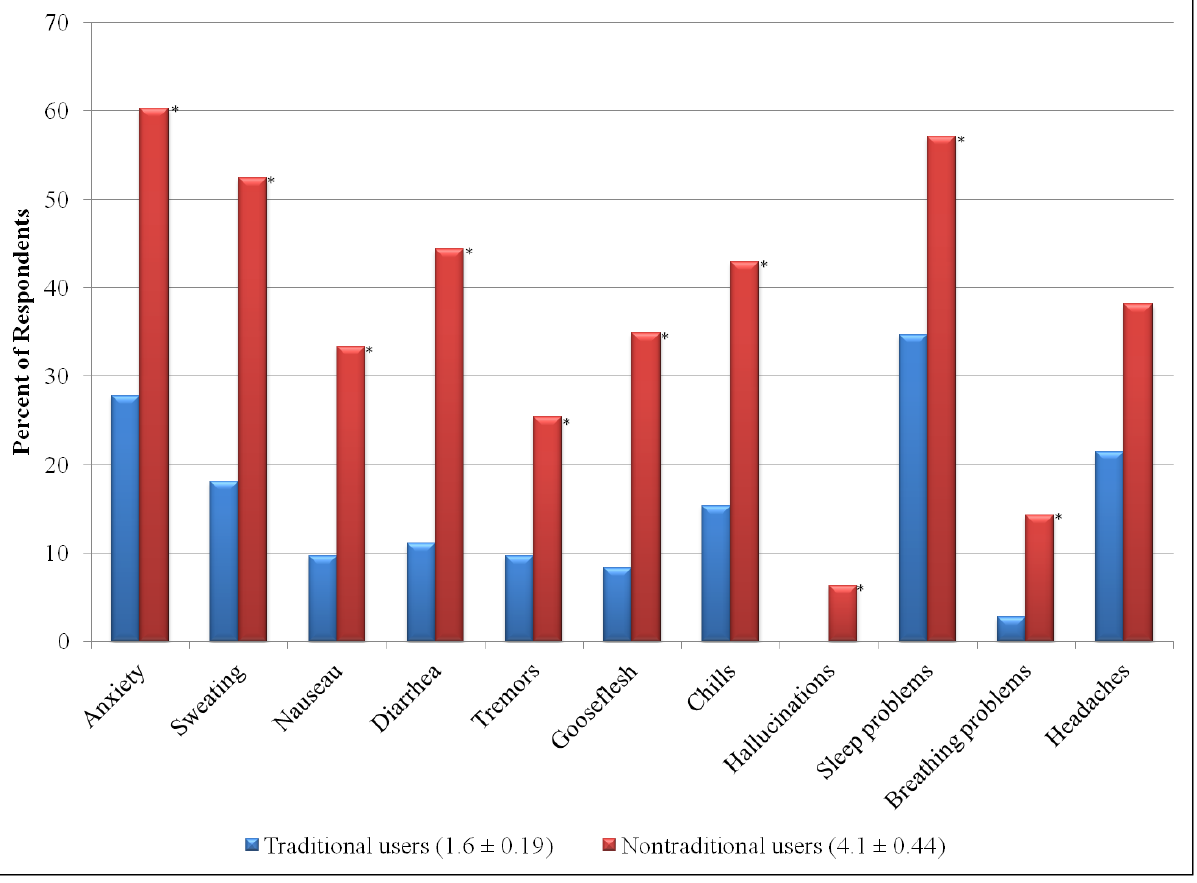
Figure 3. Percent of traditional and nontraditional users who experienced each withdrawal symptom as a result of the abrupt cessation of tramadol. Asterisks denote a significant difference ( P <.01) between groups. In addition , the legend indicates the mean number of withdrawal symptoms ± standard error experienced by both